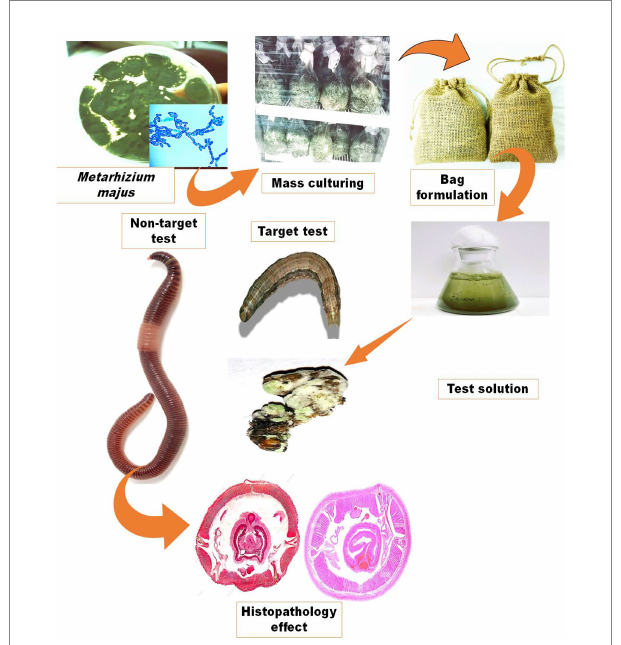
FIGURE 1 Production of an entomopathogenic fungi M. majus conidia bag formulation. The formulation preparation process and how it is used to make a fungal suspension for spray application are depicted